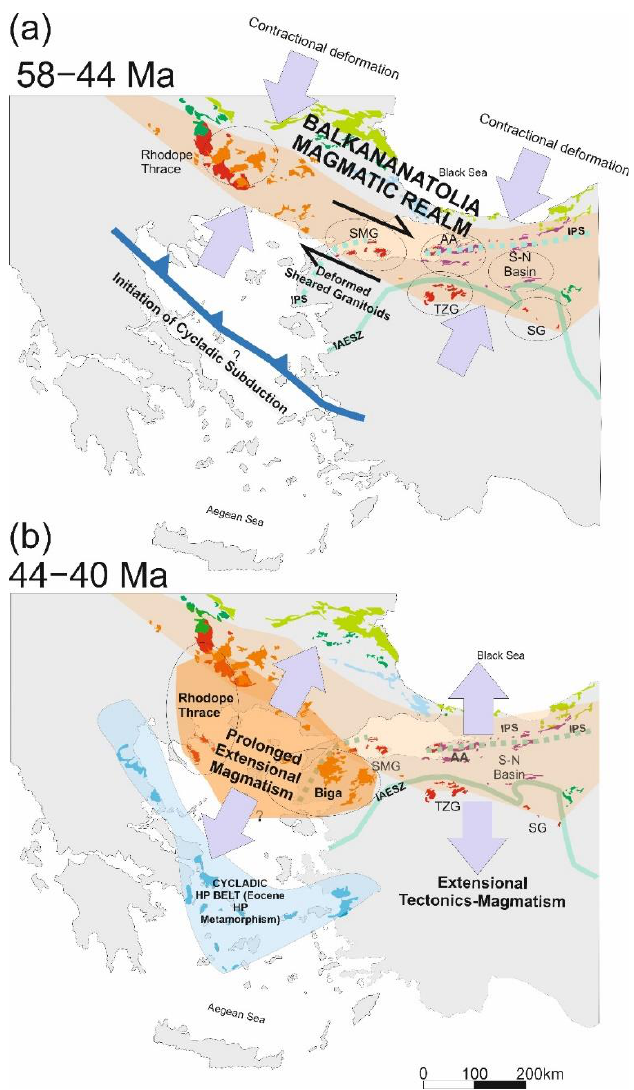
Figure 16. The geodynamic scenario proposed for the generation of the Balkanatolia Magmatic Realm. ( a ) From 58 to 44 Ma, magmatism was mostly dominated by the driving compressional deformation in Anatolide–Tauride and Pontides and was marked by the melting of the modified mantle sources. ( b ) After 44 Ma, Cycladic HP metamorphism became more pronounced and was possibly due to the roll-back of the subducting Pindos–Neotethyan slab giving rise to extensional deformation and prolonged magmatism in the Biga Peninsula and Rhodope–Thrace. In contrast, magmatism along NW Anatolia and the main portion of western Anatolia continued with cessations and did not persist during the Early Oligocene.